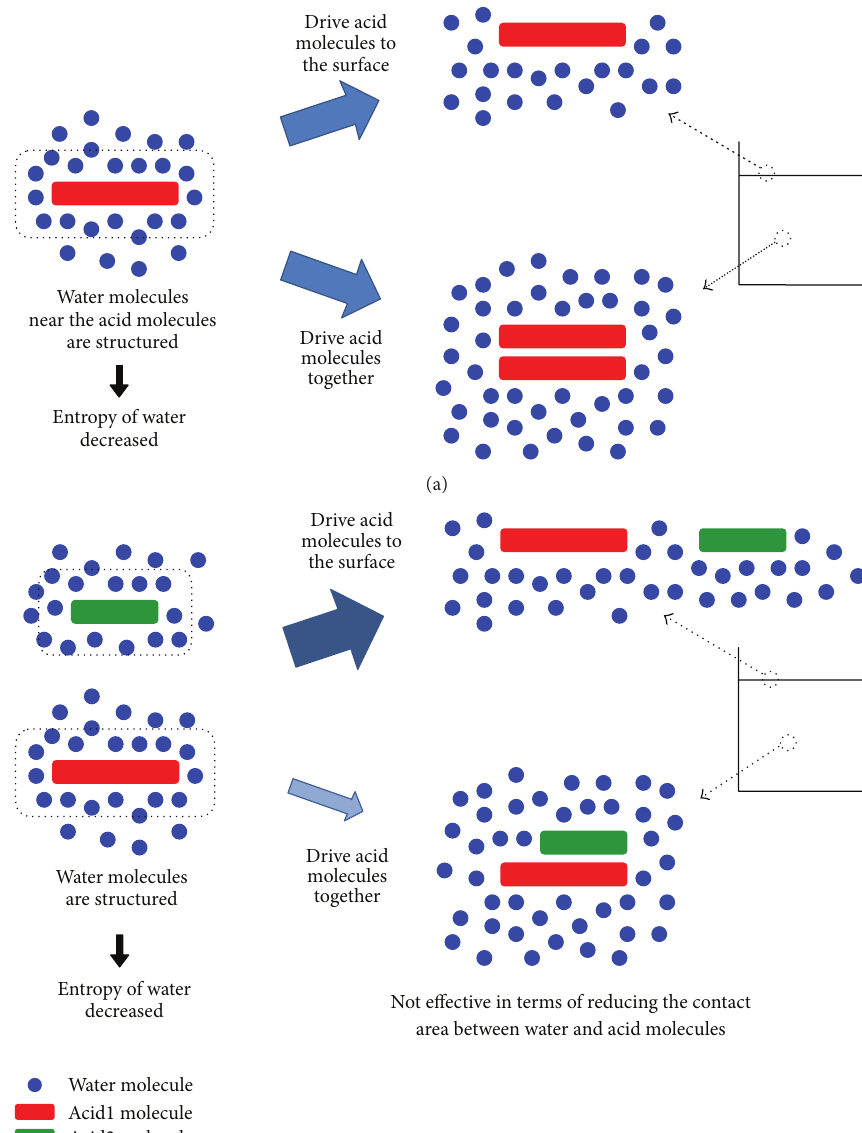
Figure 6: Illustration of hydrophobic effect for (a) a single-compound solution and (b) a mixed solution. The width of each arrow reflects the strength of that